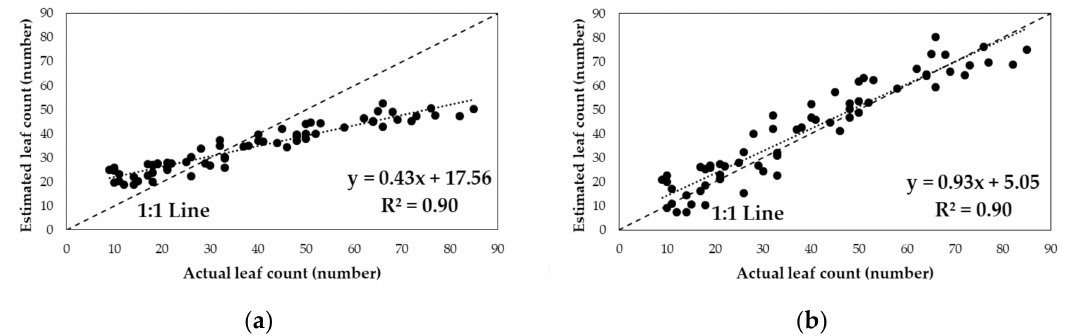
Figure 16. Examples of improving the relationships between the actual and estimated leaf count of Chinese cabbage ( a ) before and ( b ) after two-point